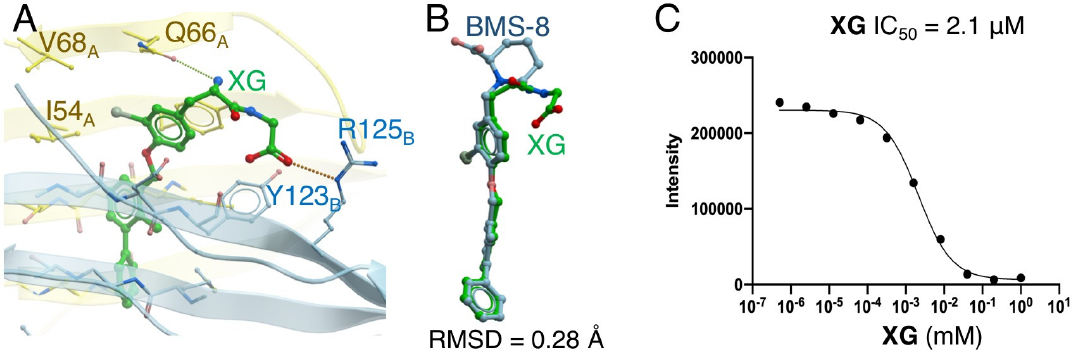
Figure 7. In silico binding mode of XG . ( A ) Behavior of XG in the binding pocket of the PD-L1 AB homodimer. ( B ) Superposition of XG onto BMS-8 . The RMSD for displacement was 0.28 Å. ( C ) IC 50 of XG for PD-1/PD-L1 binding.